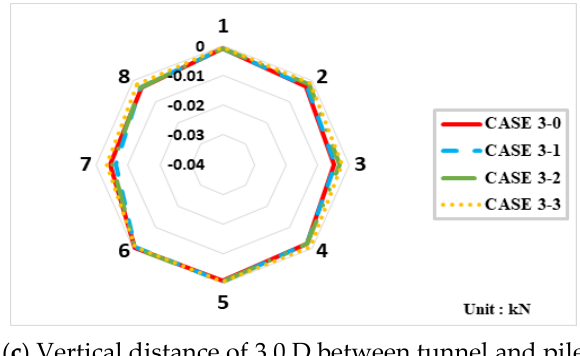
Figure 23. Axial force on tunnel by allowable load in 3D numerical analysis.